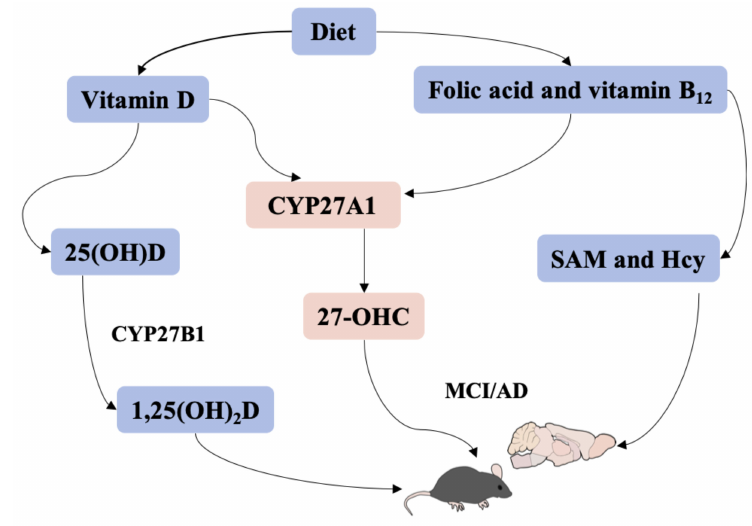
Figure 8. A graphic